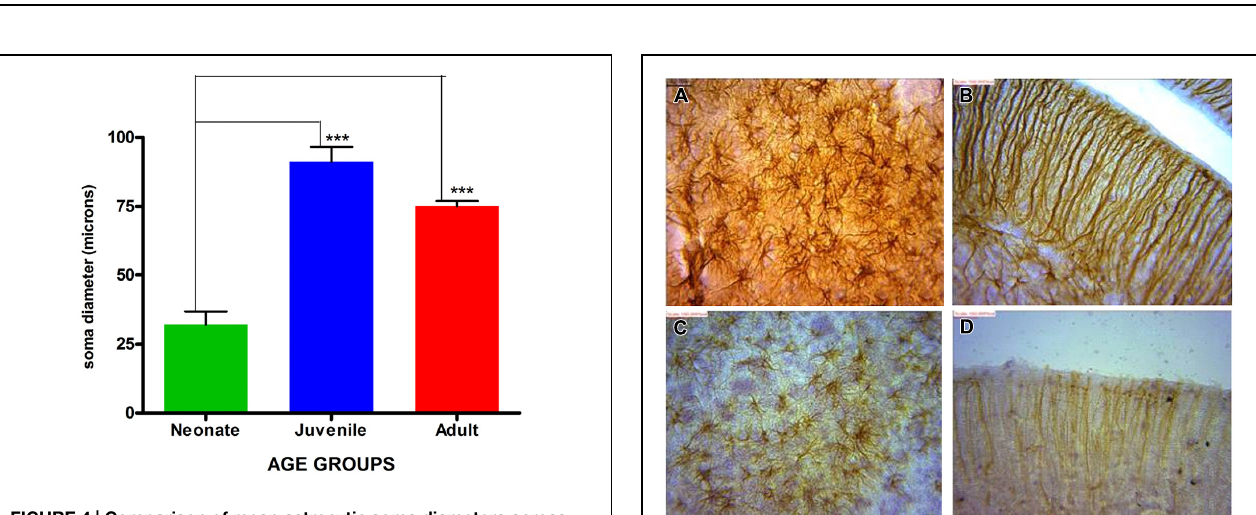
FIGURE 4 | Comparison of mean astrocytic soma diameters across age groups. Values are expressed as means ± SEM. ∗∗∗ indicates significant statistical difference at p ≤ 0.01.